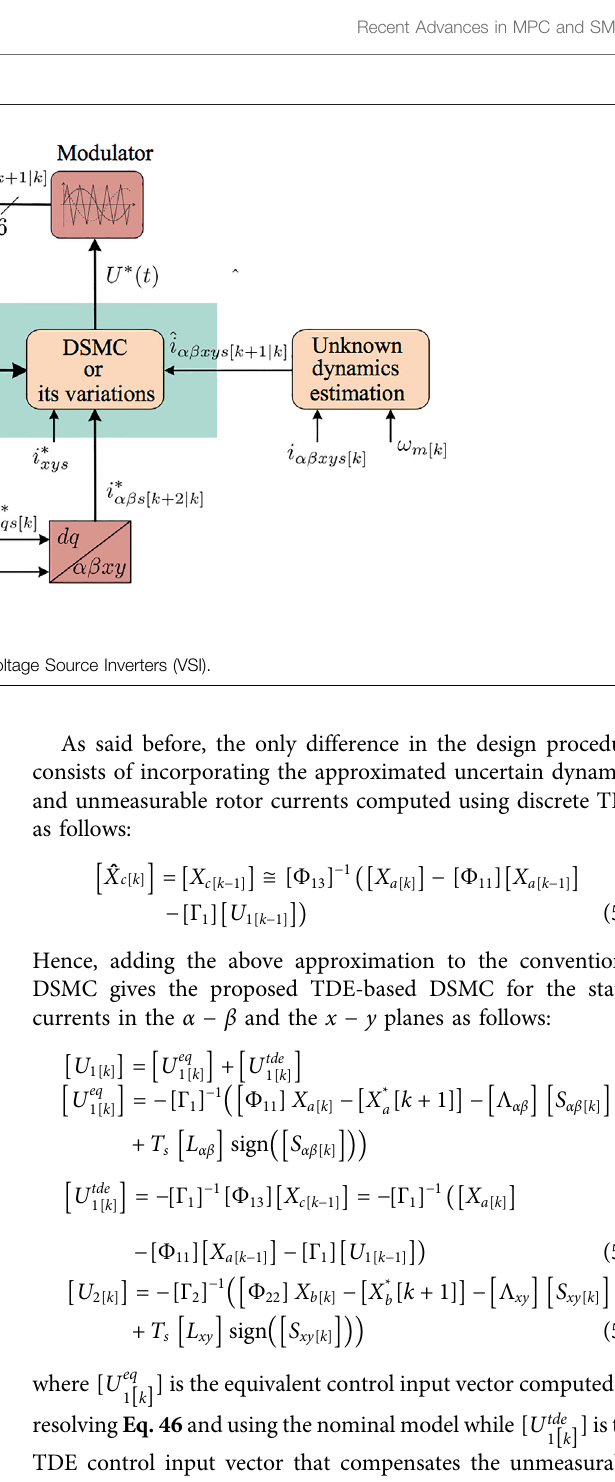
Frontiers in Energy Research |